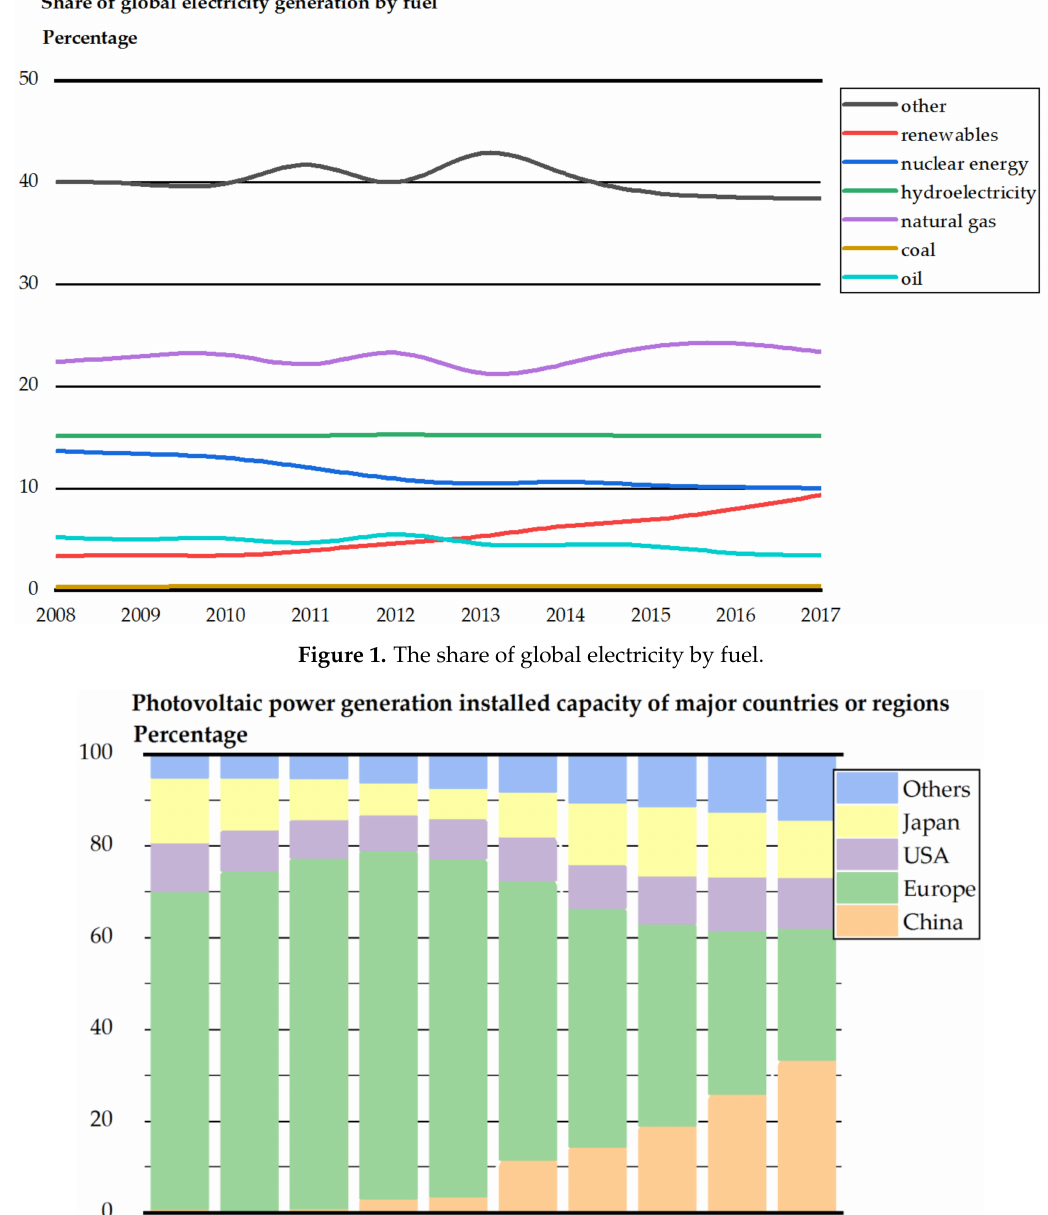
Figure 2. Photovoltaic power generation installed capacity ratio of major countries or